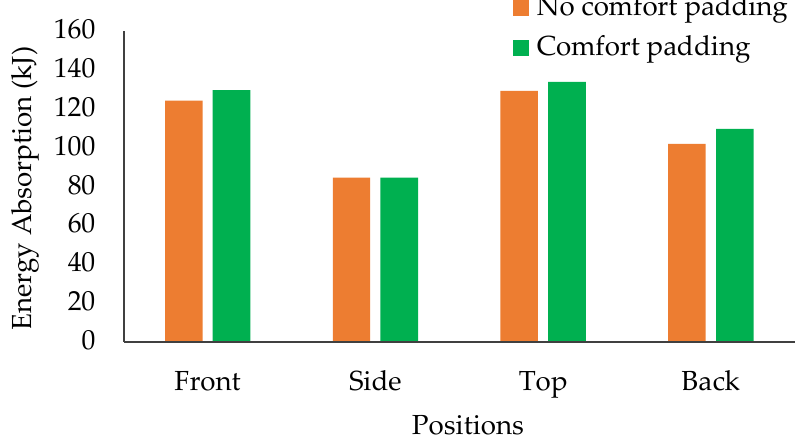
Figure 7. Energy absorption with different positions under the impact test.